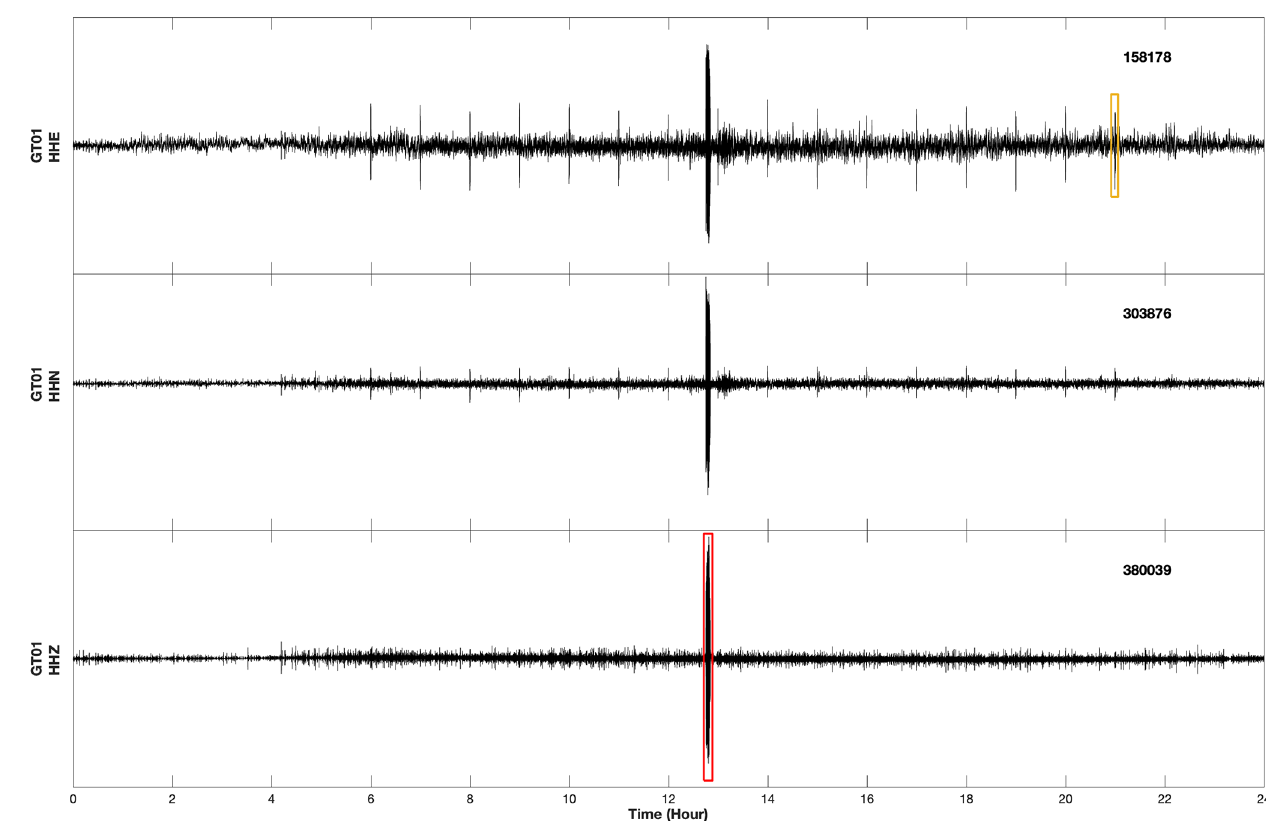
Figure 3. 24h of continuous seismic data recorded on three channels (HHE, HHN, HHZ) at the seismic station GT01, which is housed in the bell tower of the Wills Memorial Building. The orange box on the HHE (top) trace highlights the bell chimes at 22:00LT (21:00UTC). The red box shows the much larger bell-ringing for the Charter Day commemoration on 23 May 2018. Both highlighted signals are explored further in Fig. 4. The numbers in the upper right corner of each trace indicate the absolute maximum amplitude of that trace in